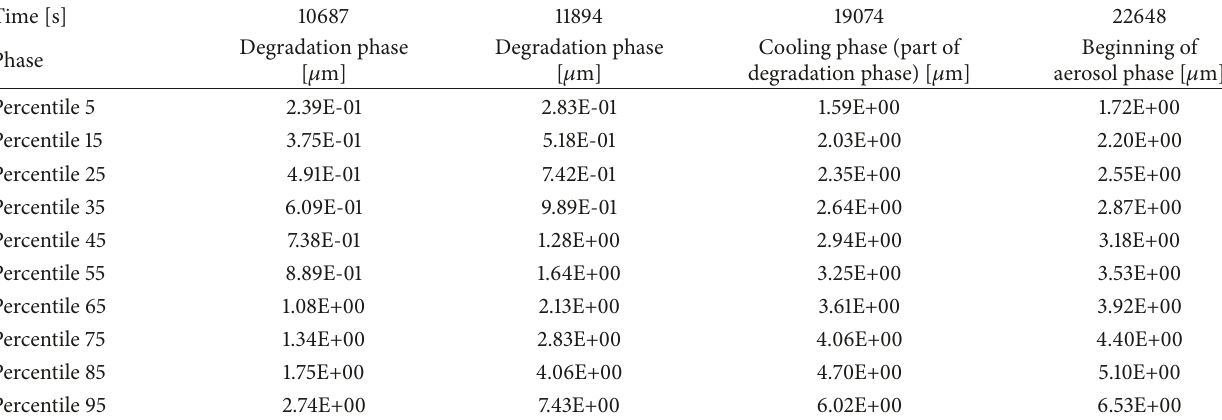
Table 10: Size distribution of Cs compounds from the degradation phase to the beginning of the aerosol phase.